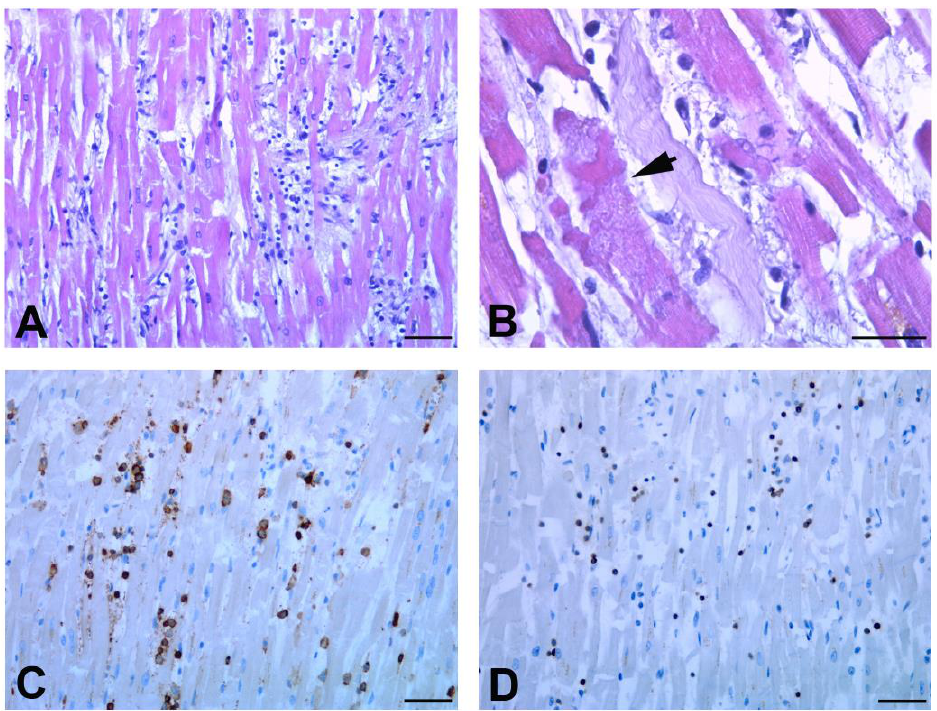
Figure 5. Histopathological feature of myocarditis in unvaccinated patients. ( A , B ) Hematoxylin and Eosin-stained sections of myocardial tissue show multifocal myocarditis, with ( A ) patchy areas of inflammatory cell infiltrates associated with (( B ), arrow) myocyte necrosis. ( C , D ) Immunophenotypic characterization of inflammatory cells, identify the presence of ( C ) CD45+ leukocytes and ( D ) CD3+ T lymphocytes, according to definition of myocarditis. Scale bars: ( A , C , D ) = 28 µm; ( B )= 30 µm.